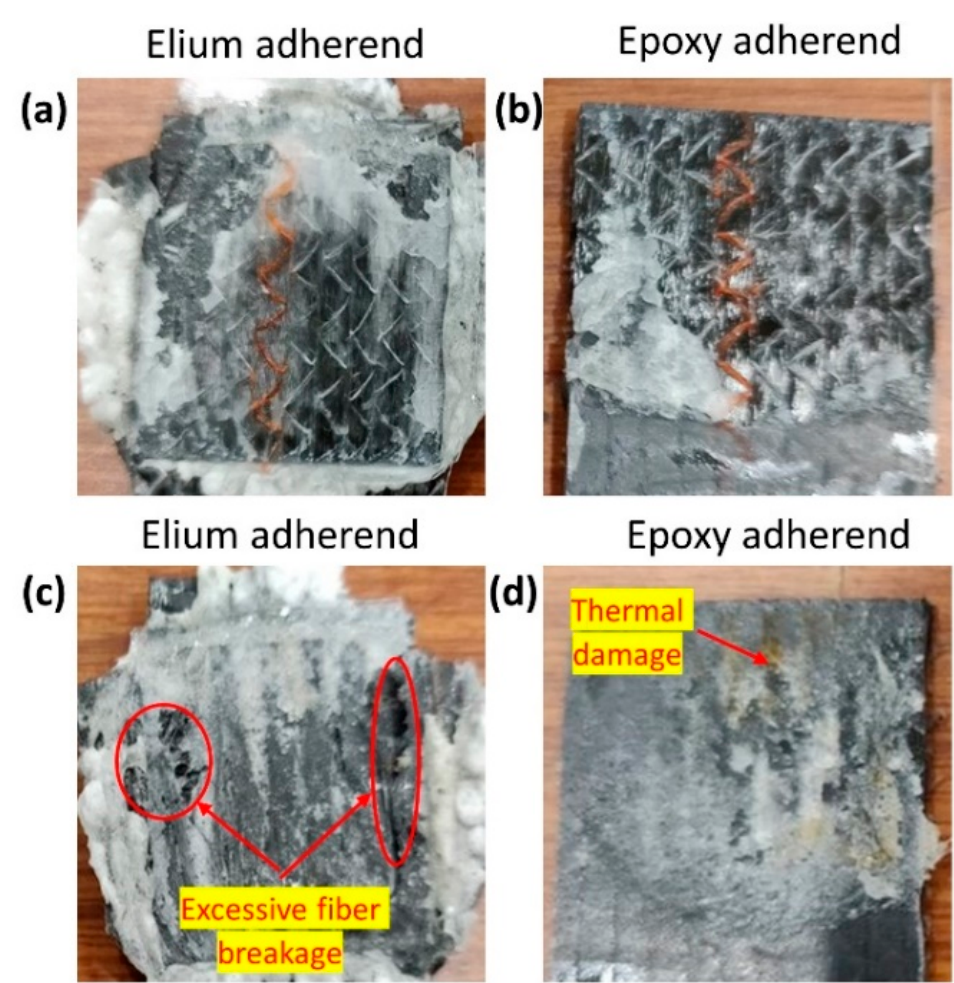
Figure 10. Fracture surfaces of EL-EP(Elium ® -Epoxy)_0.25 at ( a , b ) maximum Lap shear strength and ( c , d ) minimum Lap shear strength.